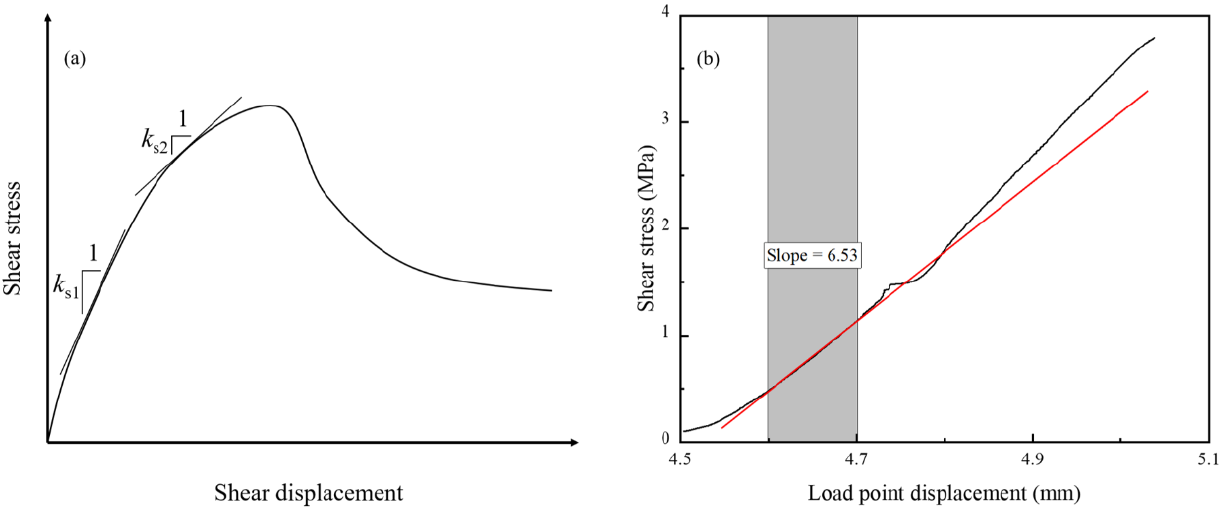
Figure 3. Shear stiffness calculation. ( a ) Typical stress-related displacement [57]. ( b ) Loading curve of direct shear test. The red line is the best-fitting line with the smallest error for the loading curve, which is fitted by the curve in the shade.